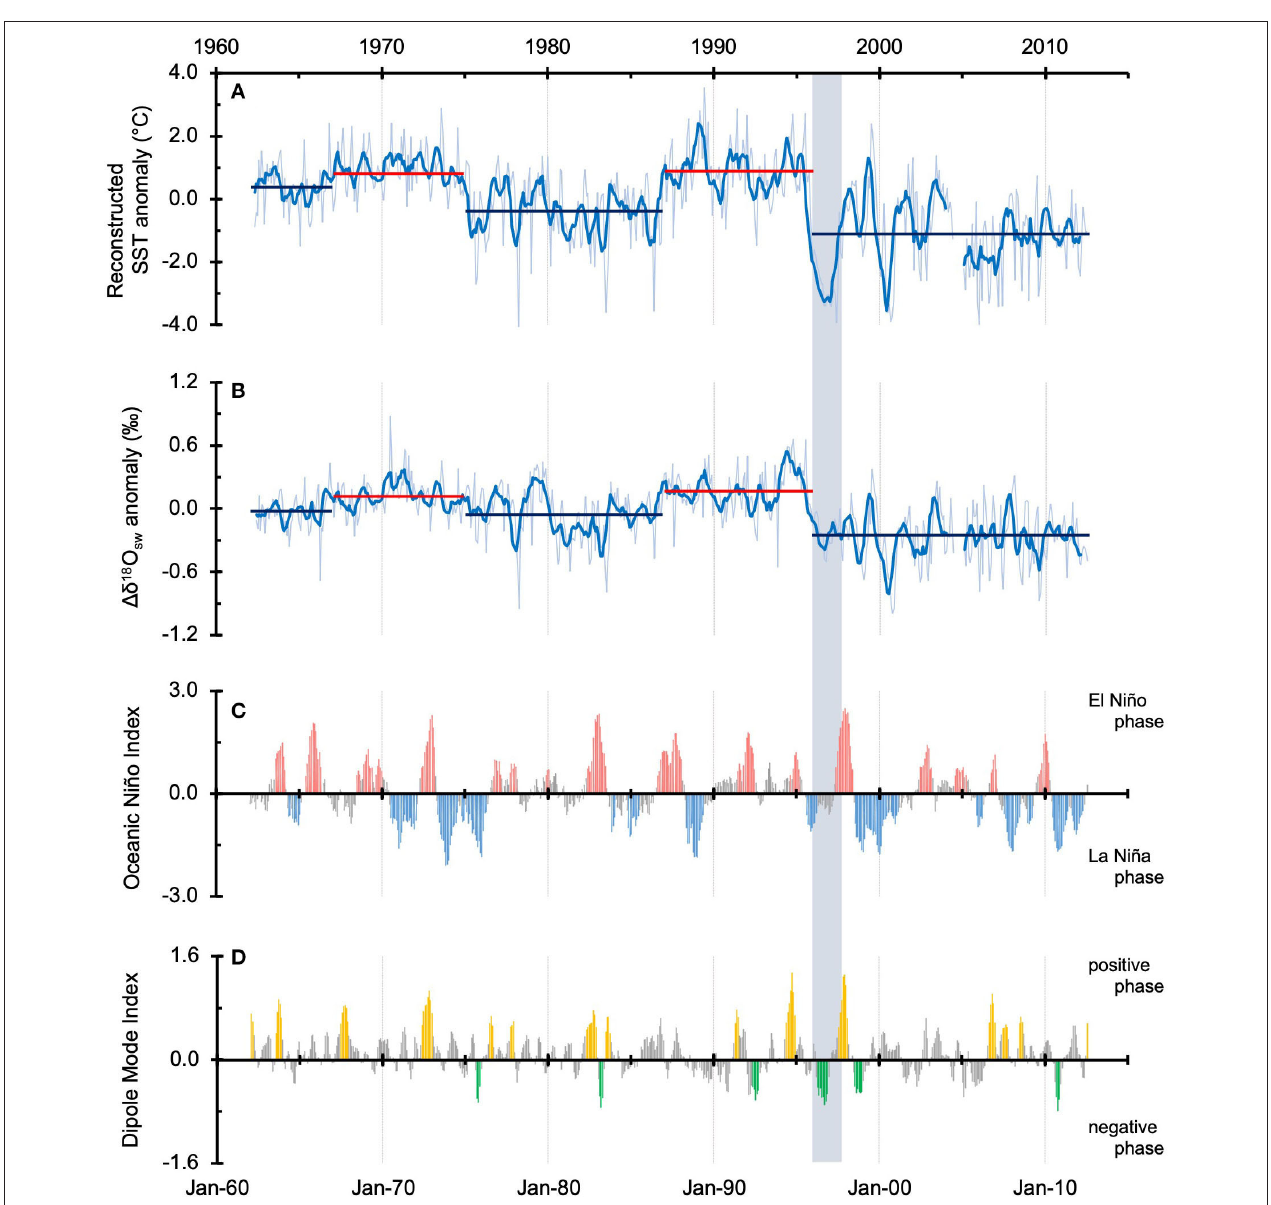
FIGURE 6 | Temporal record of (A) SST anomaly, and (B) 1 δ 18 O sw anomaly from core BAL13-09 for the period 1962–2012. Time series show monthly values (thin lines) and 6-month moving averages (thick solid lines). Red bars indicate periods of warm and saline conditions: 1967–1974 ( + 0.8 ◦ C, + 0.1%) and 1987–1995 ( + 0.9 ◦ C, + 0.2%). Blue bars indicate periods of cool and fresh condition: 1962–1966 ( + 0.4 ◦ C, 0.0%), 1975–1986 ( − 0.4 ◦ C, − 0.1%) and 1996–2012 ( − 1.2 ◦ C, − 0.3%). Time series of (C) the Oceanic Niño Index and (D) the Dipole Mode Index for the period